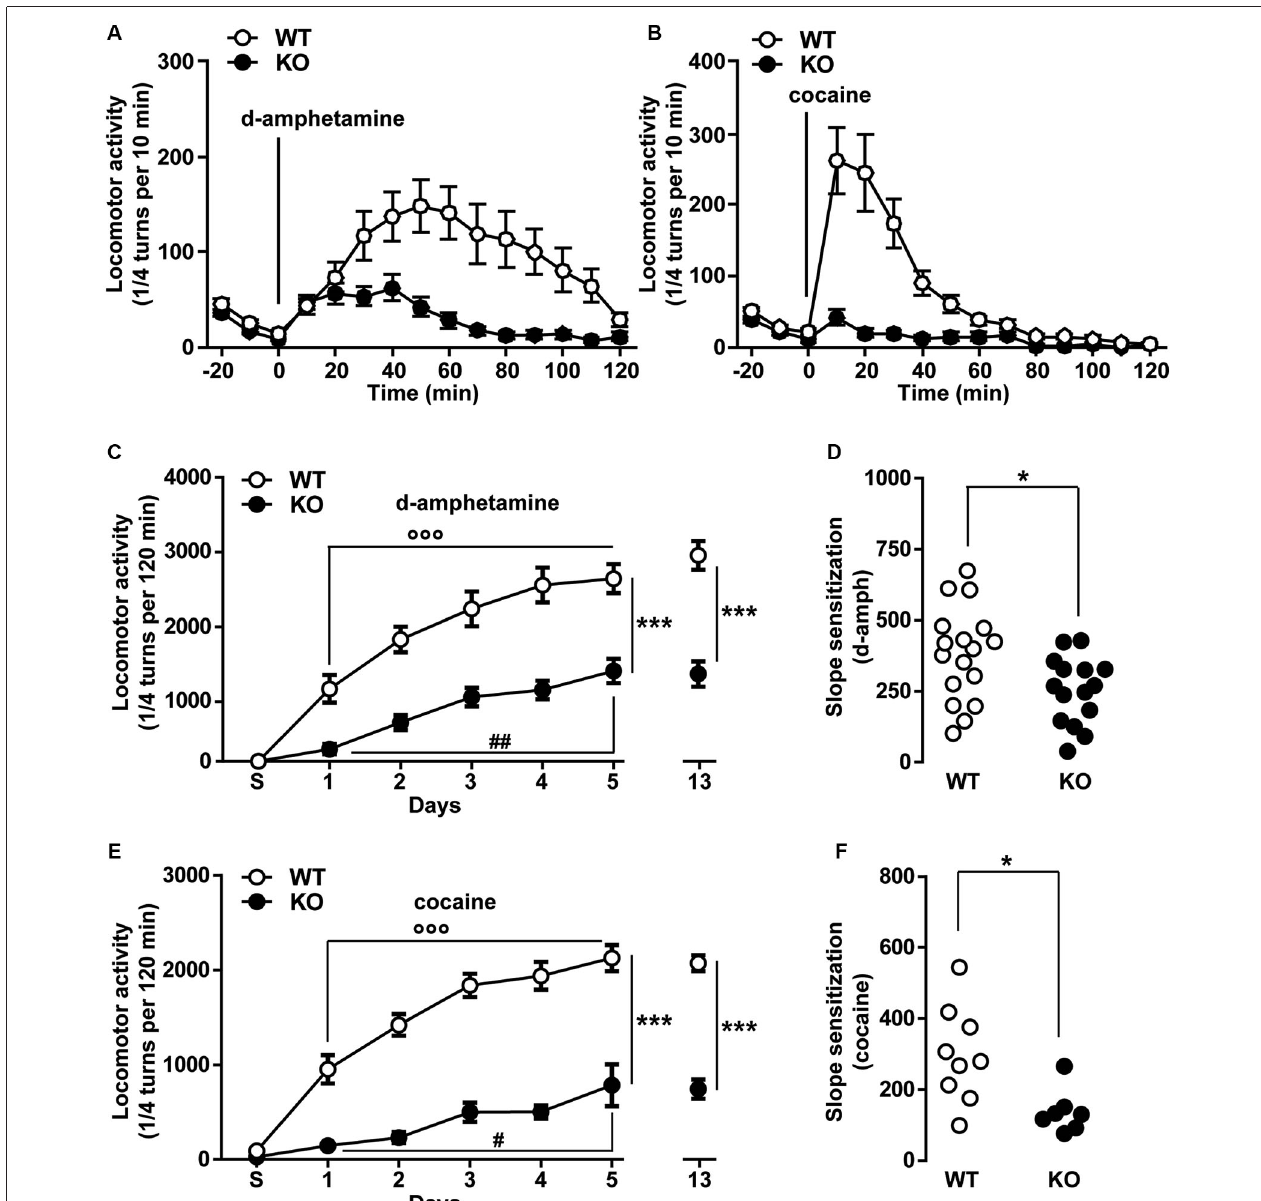
0.0001; Genotype: F ( 1,210 ) = 147.3, P < 0.001). Specific comparisons: *** p < 0.001 (KO vs. WT), ◦◦◦ p < 0.001 (WT-Day5 vs. WT-Day1) and ## p < 0.01 (KO-Day5 vs. KO-Day1). (D) Degree of d-amphetamine-induced sensitization measured as a slope of sensitization curves in WT ( n = 17) and Ca v 3.2 KO ( n = 15). Data (means ± SEM) were analyzed using Student’s t -test: * p < 0.05. (E) Locomotor activity induced by repeated administration (sensitization protocol) of cocaine (15 mg/kg, i.p.) in WT ( n = 9) and Ca v 3.2 KO ( n = 7). Data (means ± SEM) were analyzed using two-way ANOVA: (Treatment × Genotype: F ( 6,98 ) = 9.086, P < 0.0001; Treatment: F ( 6,98 ) = 37.96, P < 0.0001; Genotype: F ( 1,98 ) = 301.3, P < 0.0001). Specific comparisons: *** p < 0.001 (KO vs. WT), ◦◦◦ p < 0.001 (WT-Day5 vs. WT-Day1) and # p < 0.05 (KO-Day5 vs. KO-Day1). (F) Degree of cocaine-induced sensitization measured as a slope of sensitization curves in WT ( n = 9) and Ca v 3.2 KO ( n = 7). Data (means ± SEM) were analyzed using student’s t -test: * p <